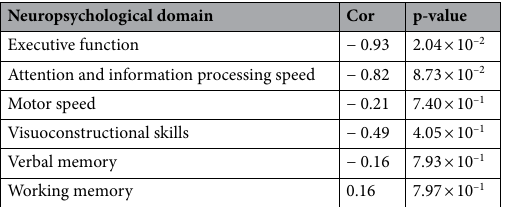
Table 5. p-value of the association between E2F4 levels and domain alteration, adjusted by age and educational level. Cor